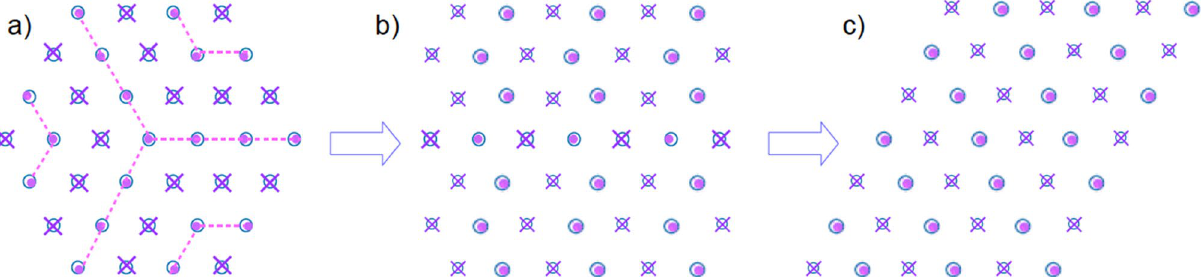
Figure 1. Depiction of the minimum energy configuration for perpendicular dipoles in a single layer, as we distort the lattice on which we grow the dipole crystal. From an hexagonal shape ( a ), whose ground state is the flag state with energy -0.919515, we obtain another minimum energy configuration where the shape is square-like, as shown in ( b ), with energy − 0.883517. Distorting the previous shape into a parallelogram ( c ), we basically obtain the first configuration (1/6th of it), with the same energy − 0.919515. Crosses represent dipoles pointing inwards, whereas dots correspond to dipoles coming out of the plane. See text for